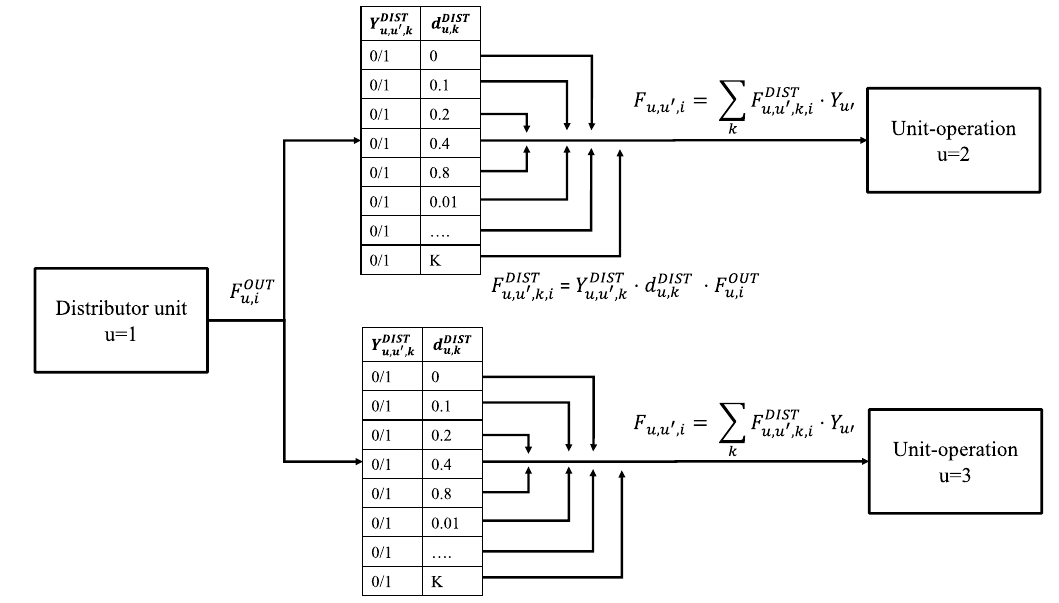
Figure 11. Concept representation of distributor unit.